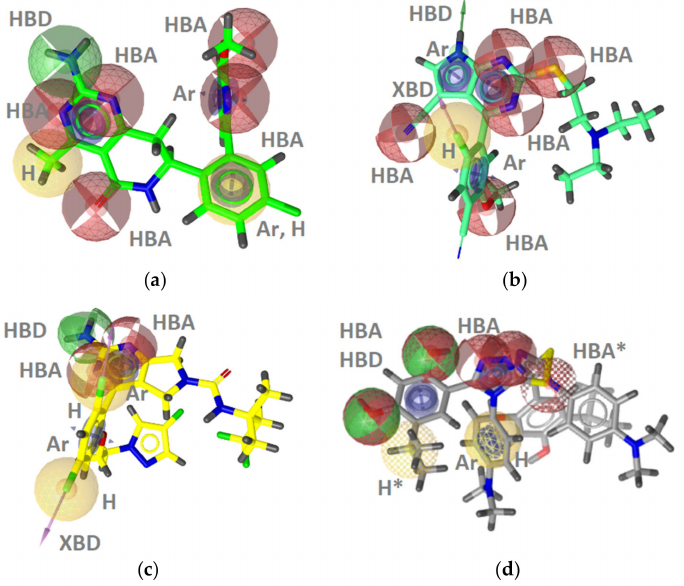
Figure 10. ( a ) LB-Hsp90-Model-3 , ( b ) LB-Hsp90-Model-4 , ( c ) LB-Hsp90-Model-5 , and ( d ) LB- Hsp90-Model-6 Hsp90 inhibitor ligand-based pharmacophore models. The pharmacophore features are as follows: hydrophobic (H, yellow spheres), aromatic (Ar, blue disc), hydrogen bond donor (HBD, green arrow, or green sphere), hydrogen bond acceptor (HBA, red sphere), and halogen bond (XBD, pink arrow). Optional pharmacophore features are marked with